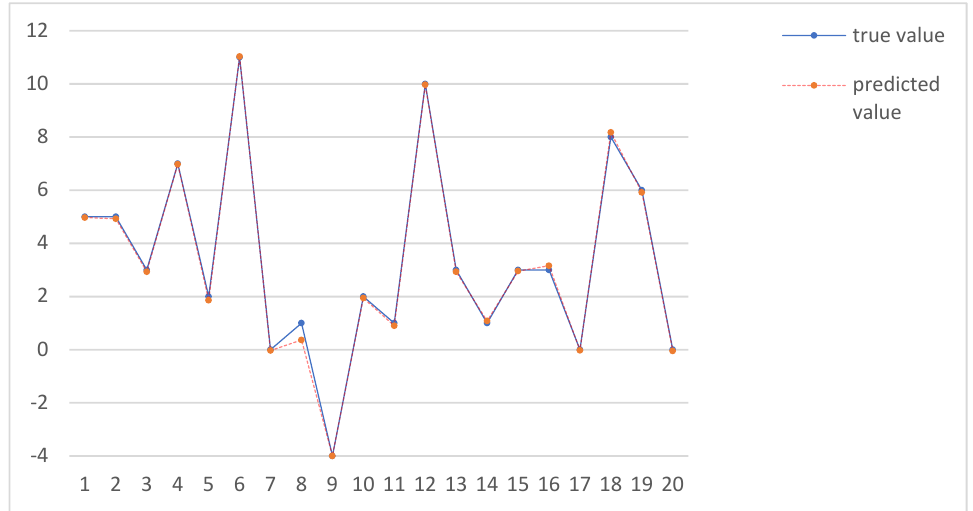
Figure 10. Comparative Analysis of Twenty Test Samples.